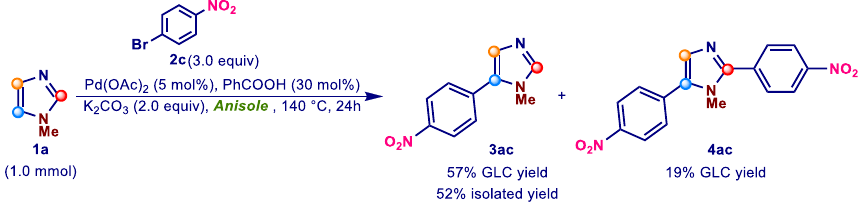
Scheme 4. Direct arylation of 1-methylimidazole ( 1a ) with 1-bromo-4-nitrobenzene ( 2c ) in SA ani-